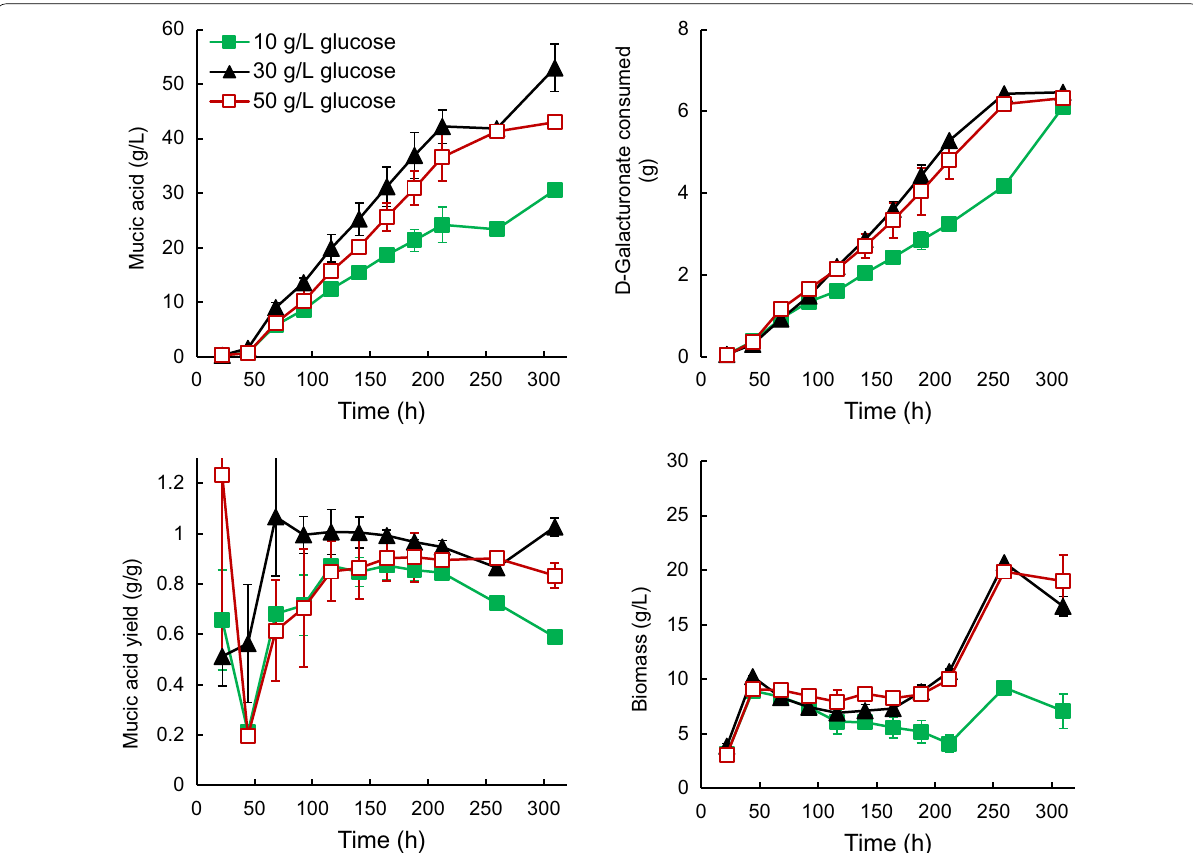
Fig. 4 Concentrations of mucic acid and biomass produced and total amount of galacturonic acid consumed, along with the yield of mucic acid on D-galacturonic acid for cultures of D-221704 grown in fed-batch culture at pH 4.0 with 10 (solid square), 30 (solid triangle), or 50 (open square) g L − 1 glucose in the feed, which also contained 94 g L − 1 D-galacturonic acid and 1 g L − 1 yeast extract. Error bars represent mean for 2